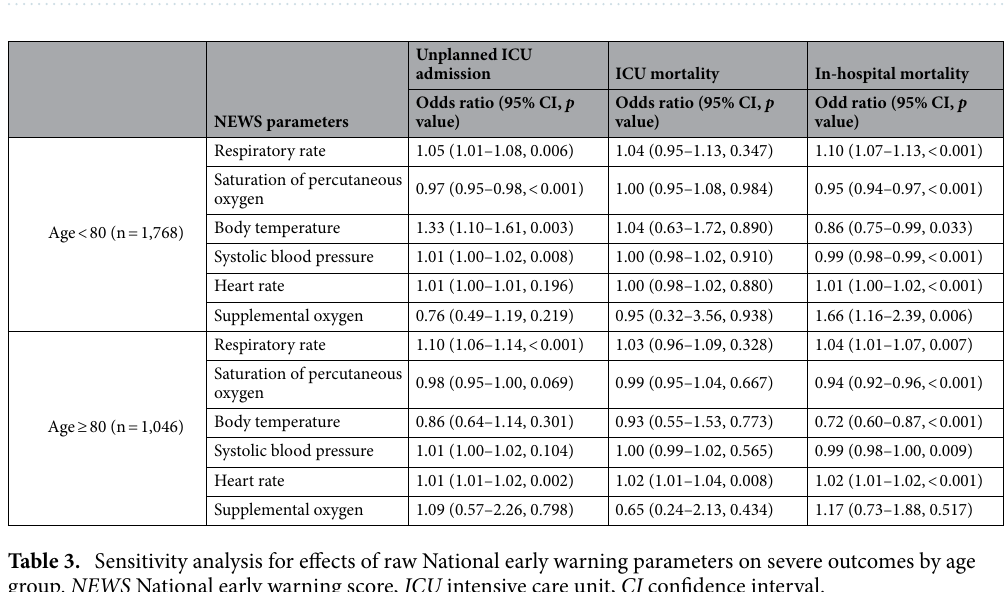
Figure 2. Effects of National early warning score parameters on severe outcomes by age group. ICU intensive care unit, OR odds ratio, CI confidence interval.